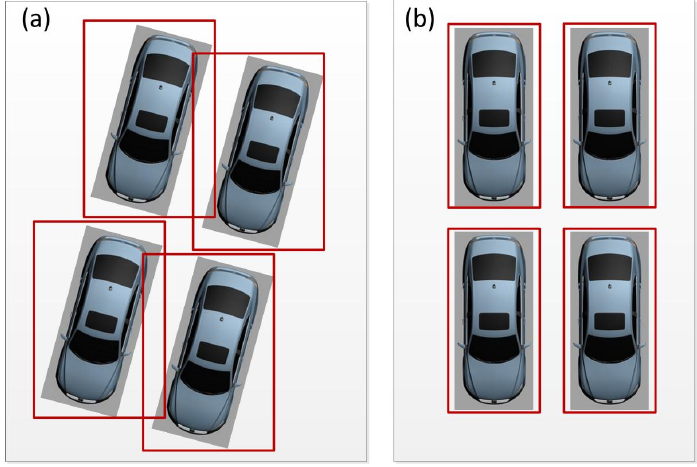
Figure 2. Bounding box of each parking space.